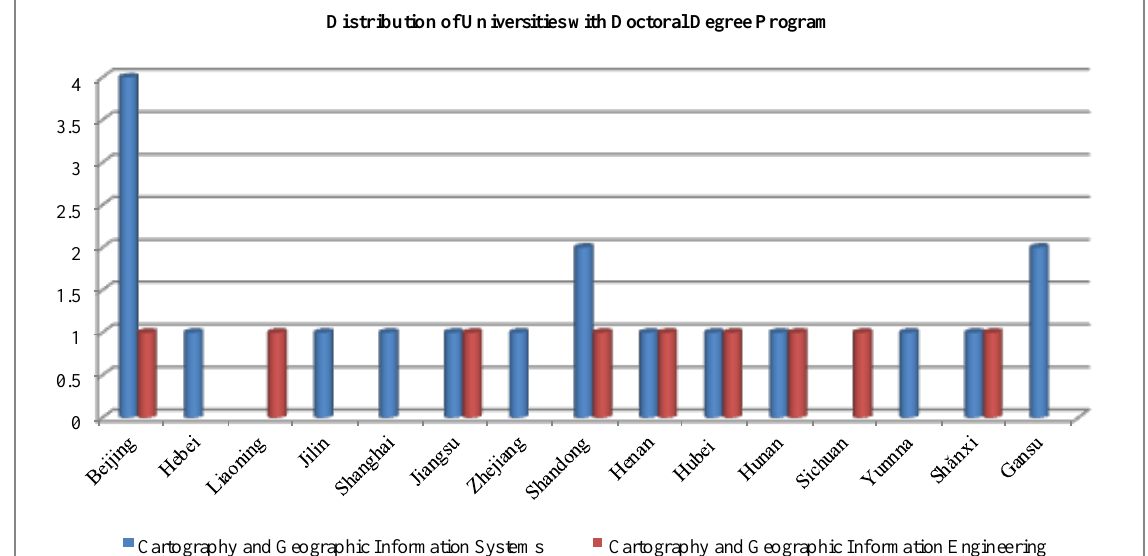
Figure 3. Distribution of Universities with Doctoral Degree